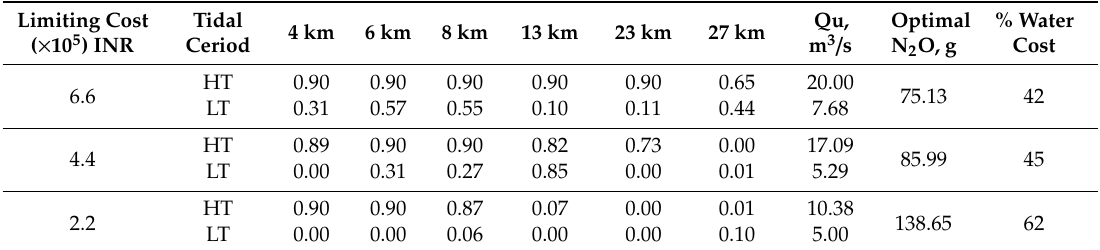
Figure 6. E ff ect of limiting cost on optimal emissions. Figure 6. Effect of limiting cost on optimal emissions. Table 3. The optimal operating schedule for Table 3. The optimal operating schedule for Case-6.